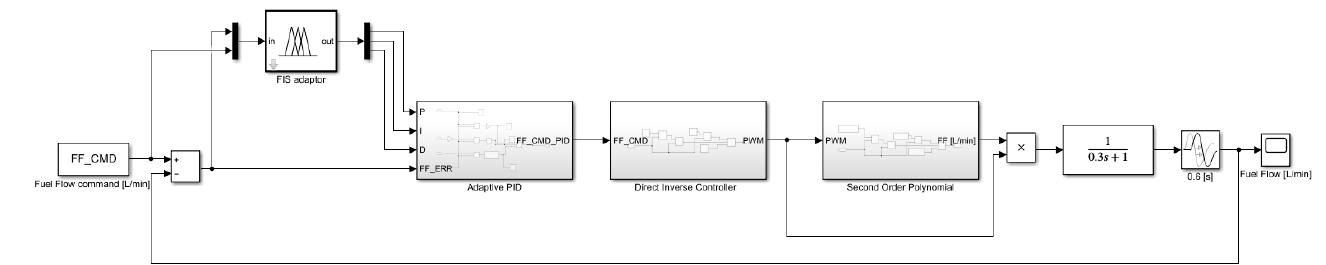
Figure 10. Fuzzy adaptive PID controller in simulation environment.